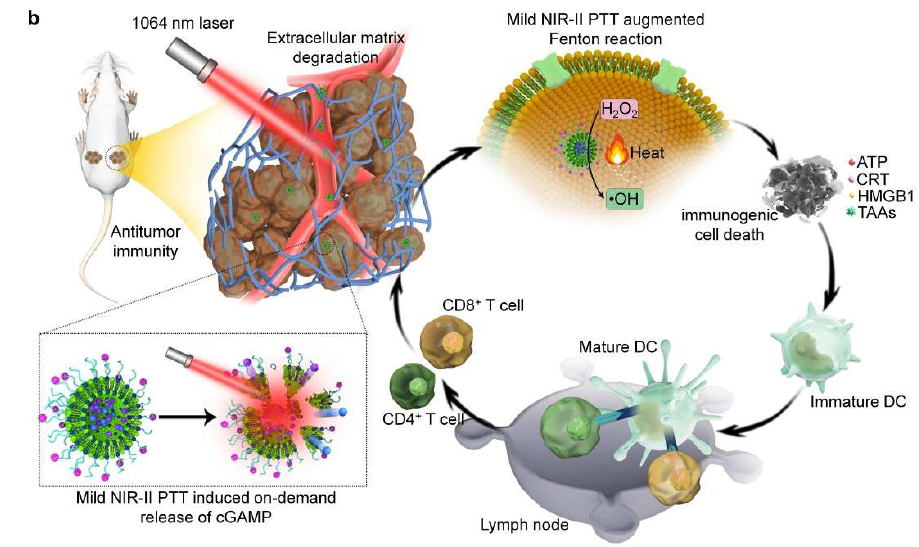
Figure 6. ( a ) A schematic illustration of the construction of ECM-degrading STING nanoagonists (dNAc) via hydration-sonication and the surface modification of bromelain. ( b ) A schematic illustration of the NIR-II photoactivation of dNAc for mild photothermal effect-augmented CDT-immunotherapy. Reproduced with permission from [80]. Copyright 2022, Springer Nature.